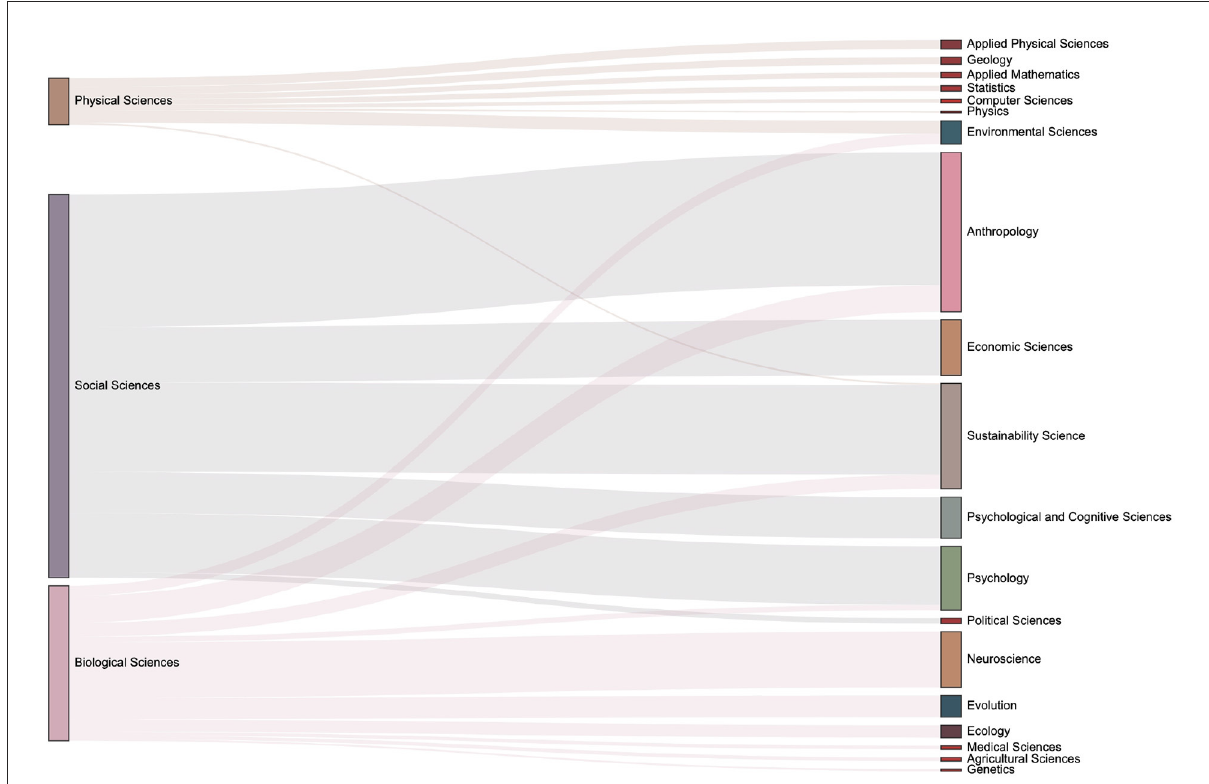
FIGURE11 The distribution of keyword mention times in various fields in the 2000s. It can be seen that more than 20 subfields have emerged during